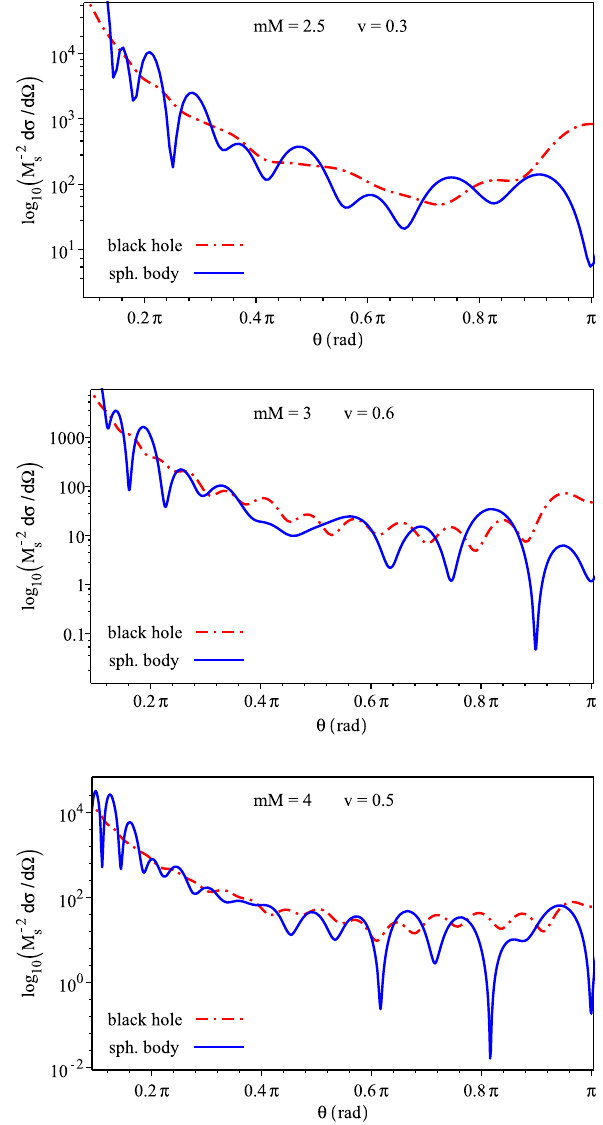
Fig. 1 Comparisonbetweenthescatteringbyamassivesphericalsym- metric body (blue curves) and scattering by a Schwarzschild black hole (dash–dotted curves). In the backward direction ( θ ≈ π ) one can observe the presence of a glory. The oscillations in the scattering inten- sityindicatesspiral(orbiting)scattering,whichismuchmoresignificant for a massive spherical body than for a black hole the Schwarzschild radius, while λ = h / p is the quantum